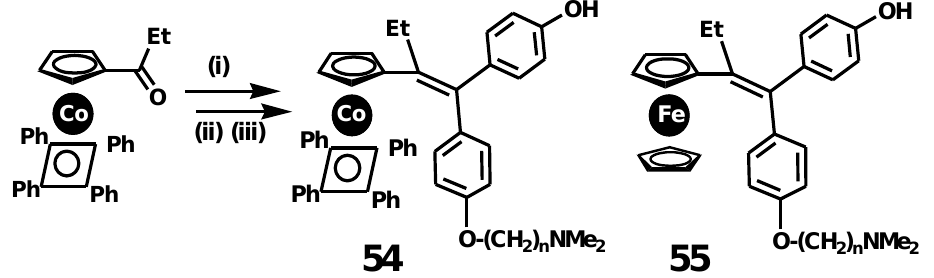
Scheme 15. Synthetic route to cobaltifens: reagents (i) ( p -HOC 6 H 4 ) 2 C=O, Zn, TiCl 4 , THF; (ii) NaH, DMF, (iii) Cl(CH 2 ) n NMe 2 , NEt 3 , THF.